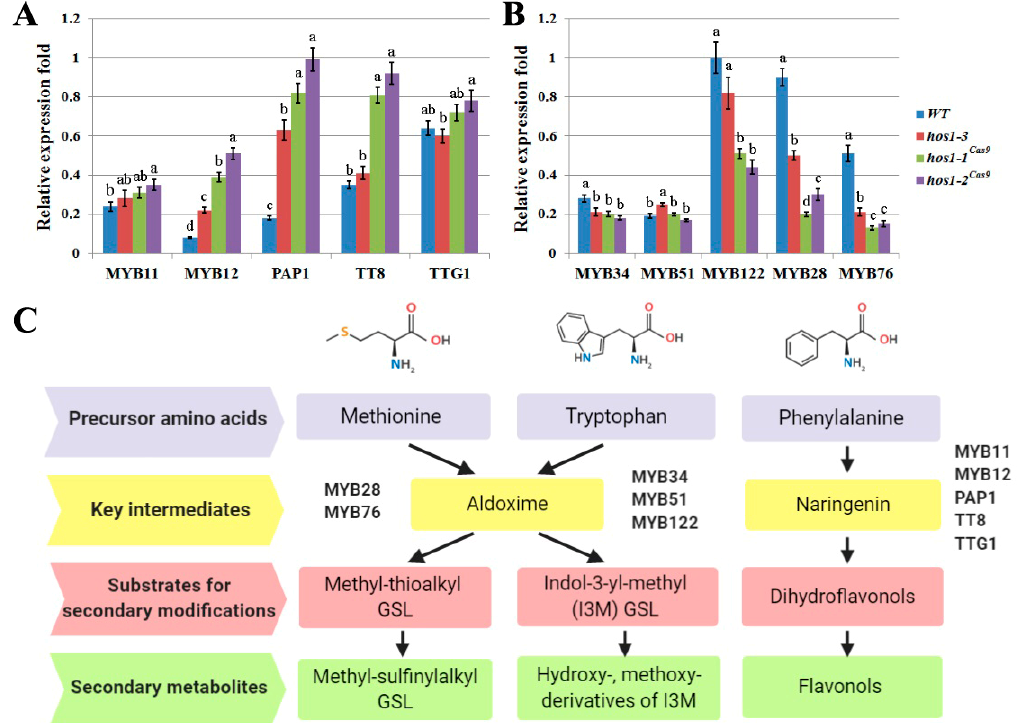
Figure 5. The relative differential expression of transcription factors involved in the biosynthesis of secondary metabolites in A . thaliana . ( A ) The expression of MYB and bHLH genes family members implicated in biosynthesis of flavonoids. ( B ) The expression of MYB genes implicated in biosynthesis of glucosinolates (GSLs). Data are presented as mean ± standard error. Different letters above the bars indicate statistically significant differences of means ( P < 0.05) for each of the genes (Fisher’s LSD). ( C ) Schematic representation of biosynthetic pathways of the particular groups of A. thaliana secondary metabolites and its transcriptional activators.